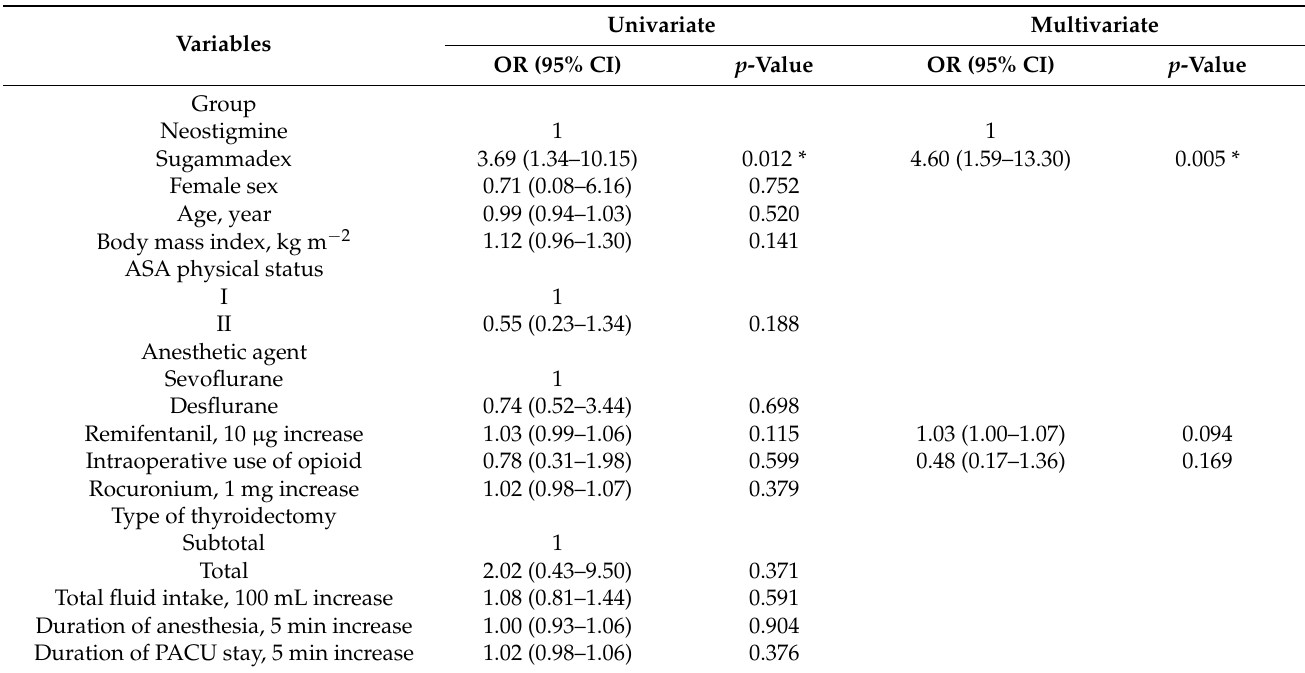
Table 4. Univariate and multivariate logistic regression analyses of the prognostic factors for the gas emission time within 24 h after robotic thyroidectomy ( n = 122).